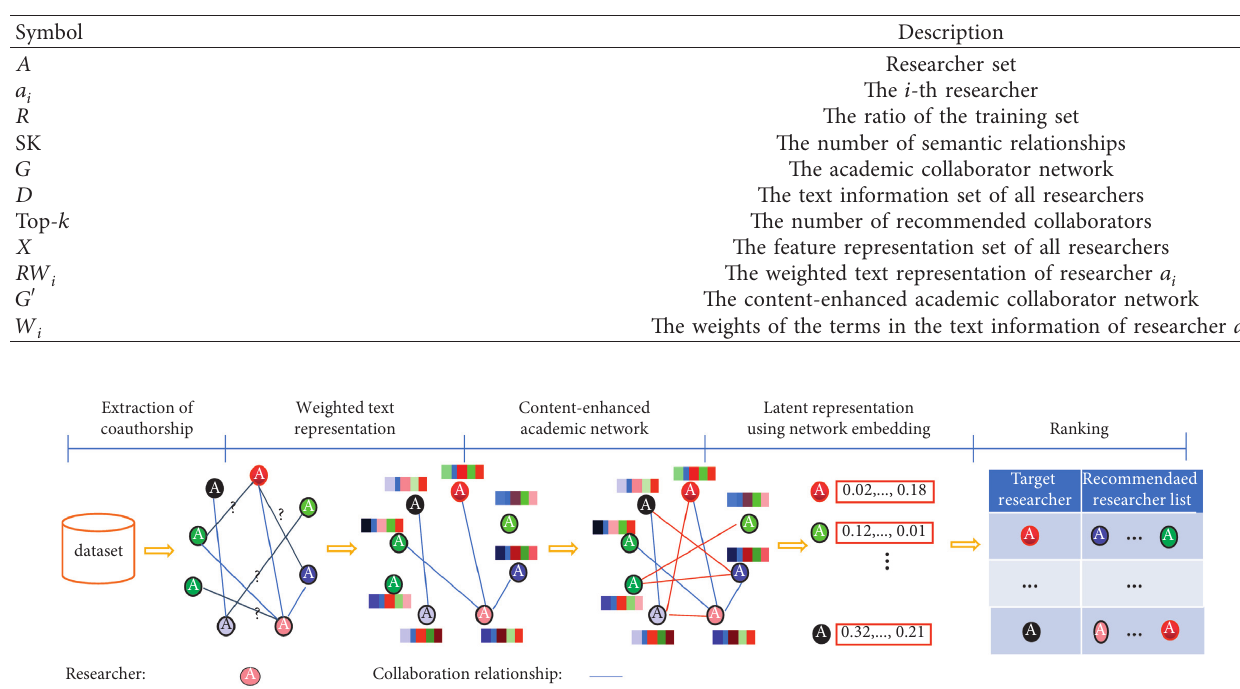
Table 1: Notations.